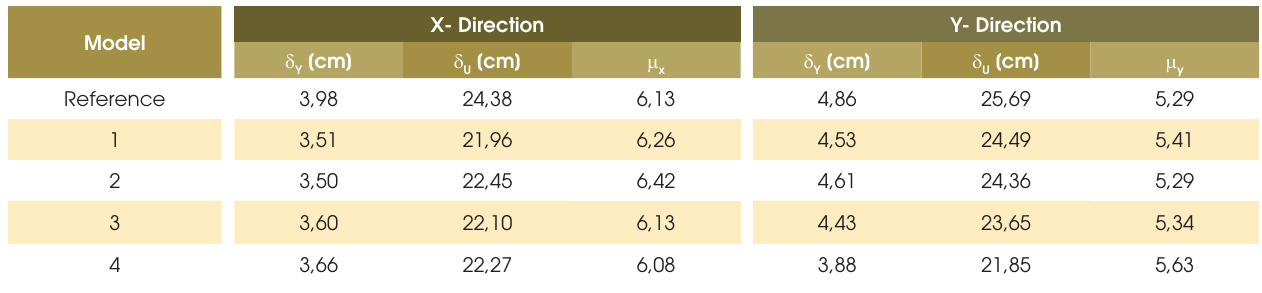
Tabela 3 – Results of bilinear models – yield and collapse displacements;